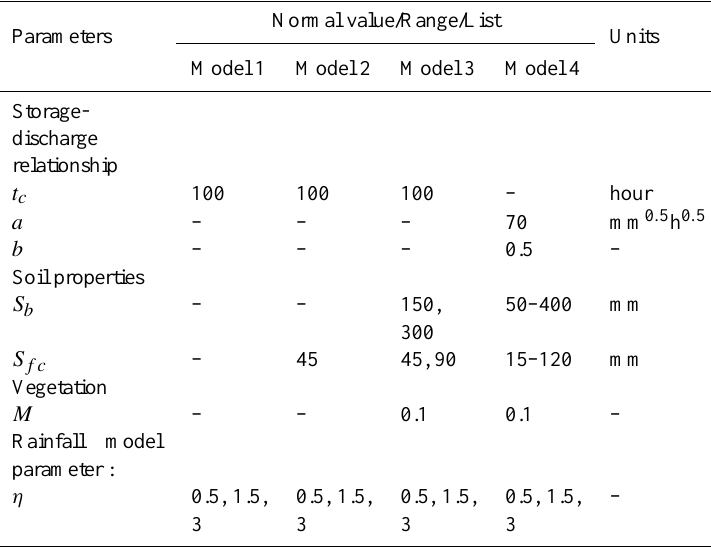
Table 2. Rainfall-runoff model